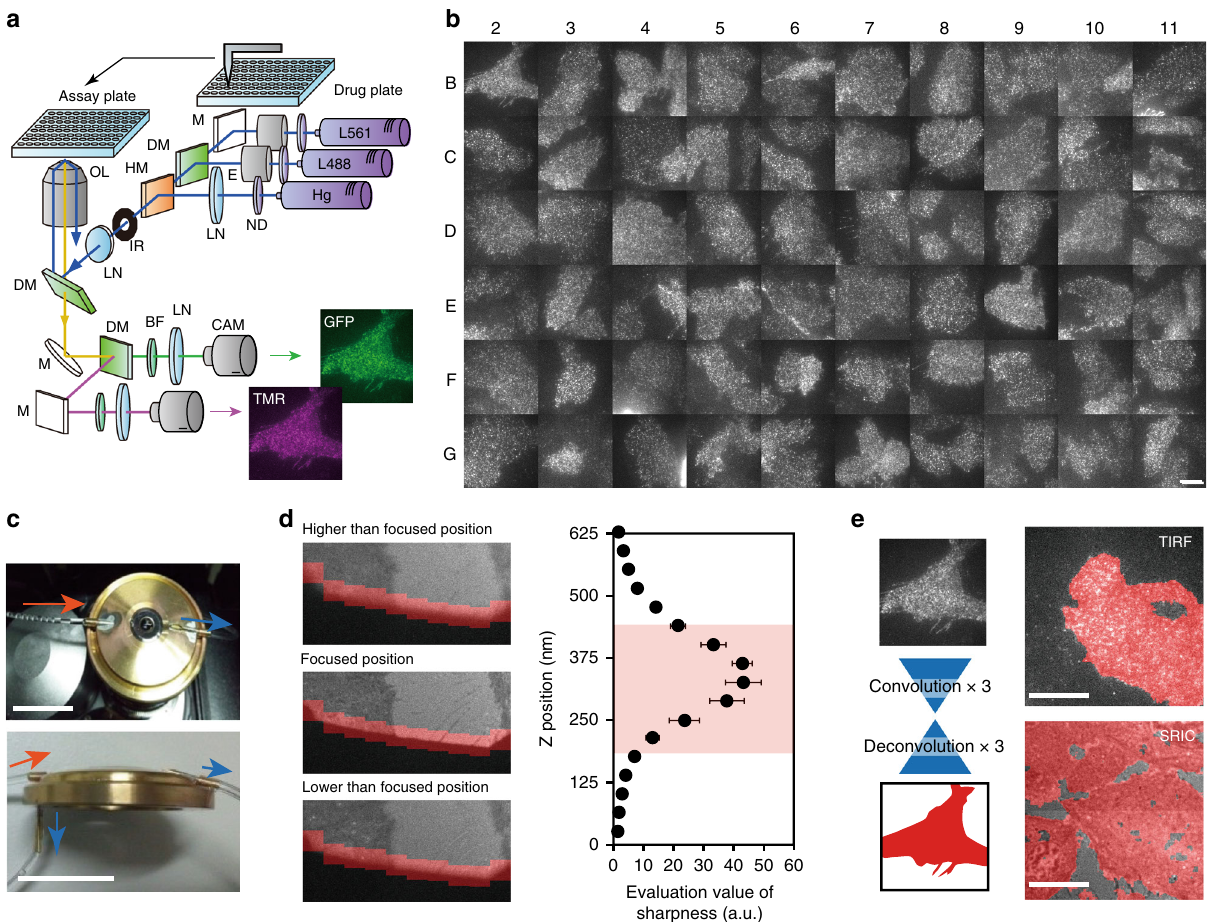
Fig. 1 Automated single-molecule imaging system. a , Schematic diagram of the system. L488 and L561 are lasers with wavelengths of 488 and 561 nm, respectively; Hg mercury lamp, OL objective lens, LN lens, DM dichroic mirror, M mirror, ND neutral density fi lter, IR iris, E beam expander, BF bandpass fi lter, CAM EMCCD camera. b Single-molecule images of EGFR-GFP in CHO-K1 cells in 60 wells of a 96-well plate (none in the peripheral wells). Alphanumeric characters indicate the well number. Scale bar: 10 µ m. c Immersion-oil feeding system. Oil fl ows into the adaptor to the objective lens (upper: top view, lower: side view. A cartoon structure is shown in Supplementary Figure 9) through one inlet in the direction of the red arrow and out two outlets along the blue arrows. Scale bars: 20 mm. d Autofocusing algorithm. Conjugated images of the iris and basal surfaces of the cells are shown for the in-focus and out-of-focus positions. Pixel intensities in the red squares on the edge of the iris are measured to calculate the evaluation values plotted in the right panel. A red background indicates Z positions observable in a nonblurry image of the fl uorescent spots. Each point consists of 5 data points. Error bars: SD. e Deep learning-based cell searching method consisting of three convolution and three deconvolution processes (left). Parameters of the neural network were adjusted by learning using training data. Cells with suitable expression of fl uorescent molecules (right, upper) and cell regions in the SRIC image (right, lower) are shown in red. Scale bars: 10 µ